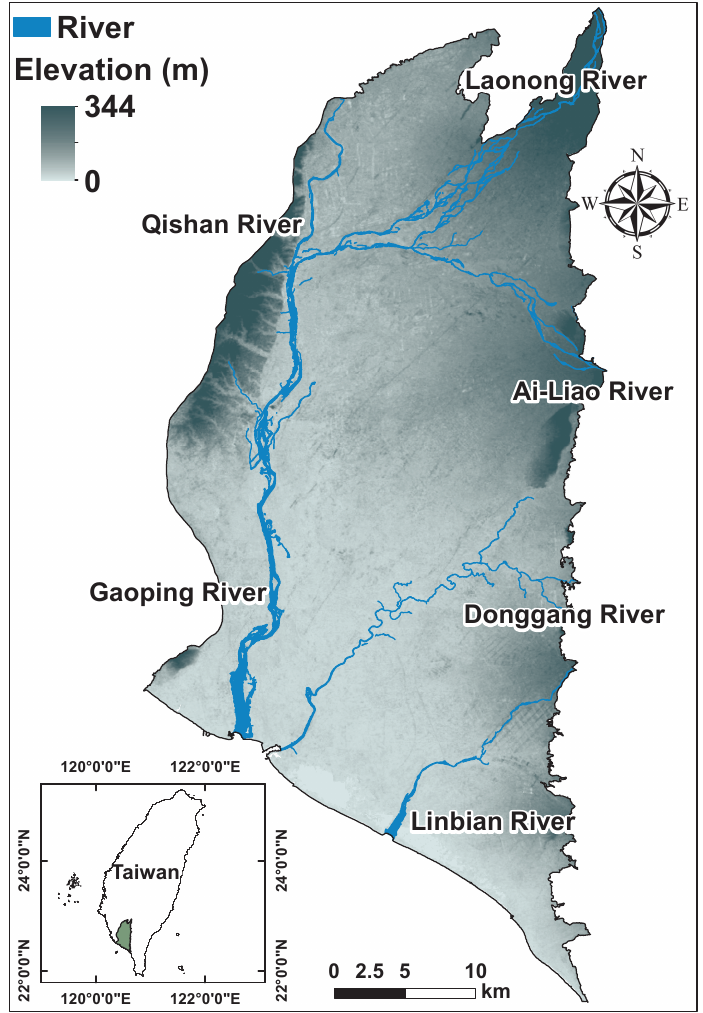
Figure 1. Map of the Pingtung Alluvial Plain (PAP) in Southwest